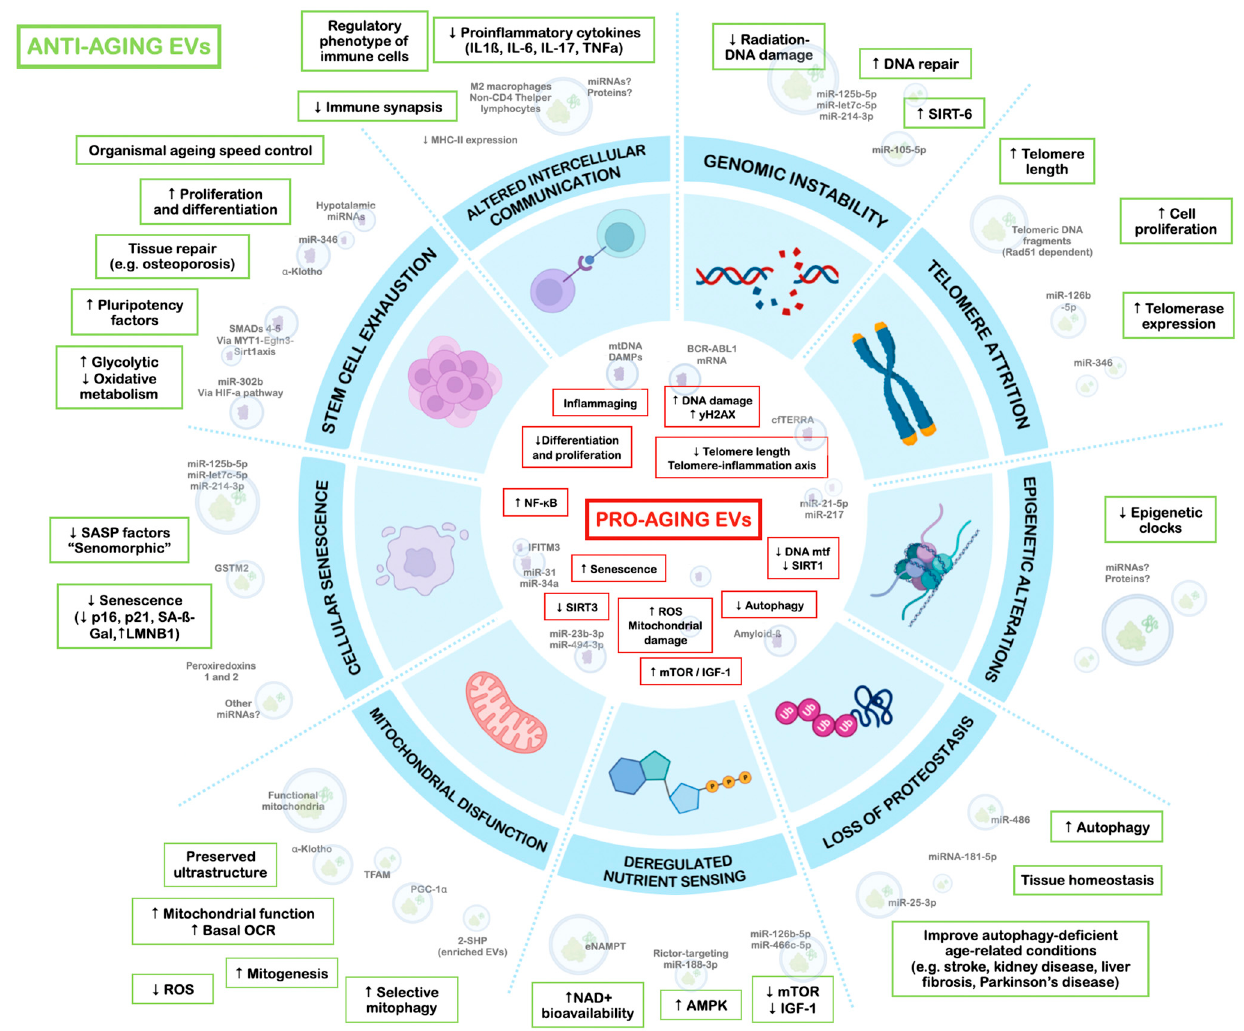
Figure 2. Graphical summary of EVs’ pro-aging (red boxes) and anti-aging (green boxes) effects on the different hallmarks, in addition to the active cargo responsible for the observed effects. Based on the original figure by Lopez-Otín et al. [52]. Created with BioRender.com